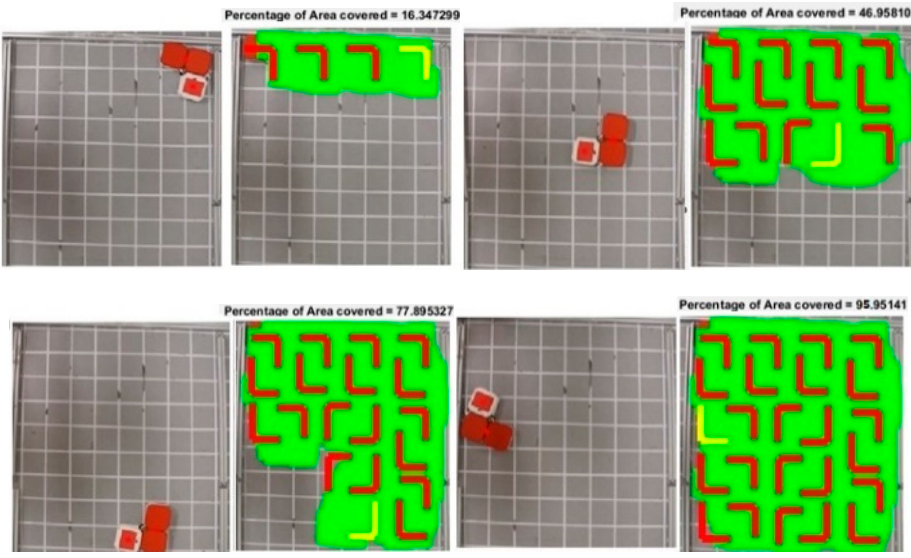
Figure 17. Experiments validating application of Theorem 2, Lemma 1.